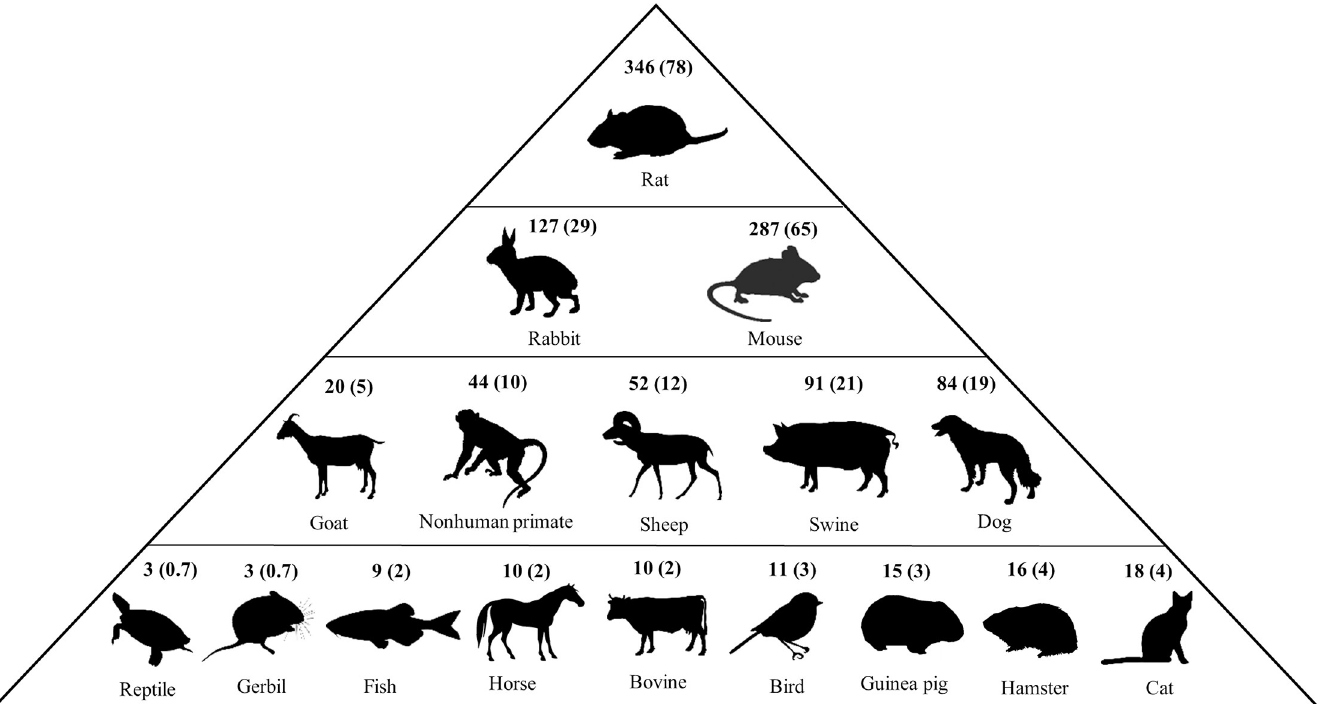
Fig 3. Infographic of animal species/class/family included in the preclinical systematic reviews. The structure of the pyramid and positioning of each species/class/ family reflects their frequency and does not reflect hierarchy. [Values represent frequency and (%).]. The figure was created using non-copyrighted biological silhouettes retrieved from